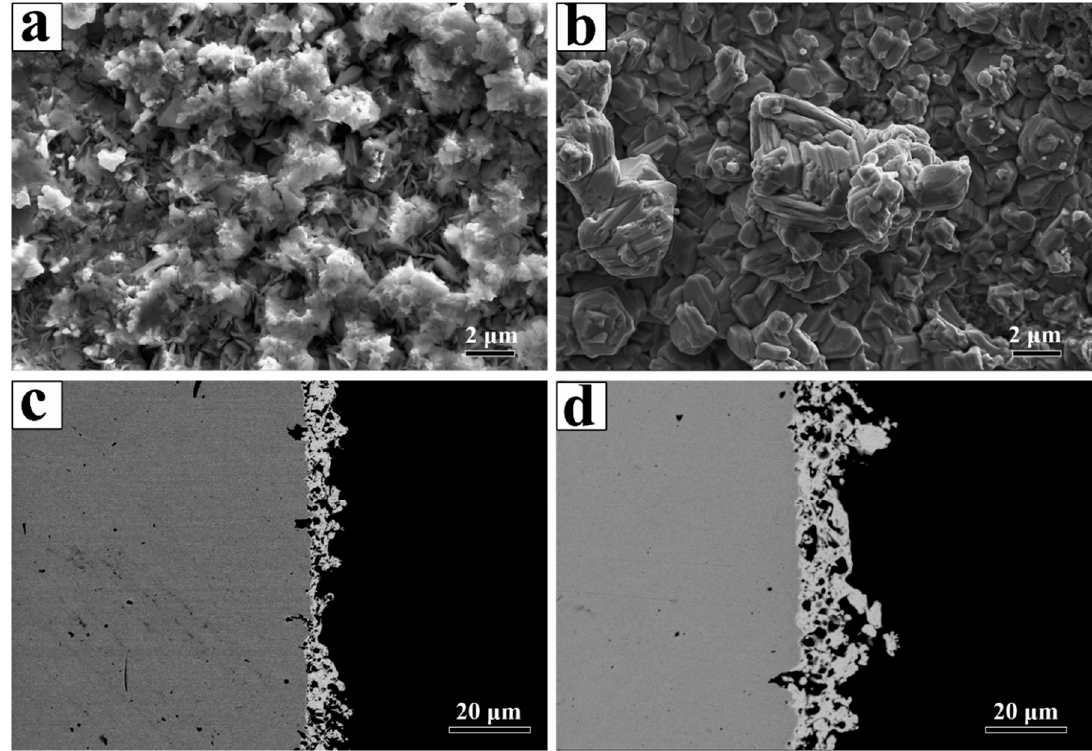
Figure 9. Zinc coating under different voltages, surface morphology: ( a ) 150 V, ( c ) 180 V; Cross-section topography: ( b ) 150 V, ( d ) 180 V. Table 2. Composition of zinc coatings shown in Figure 8.